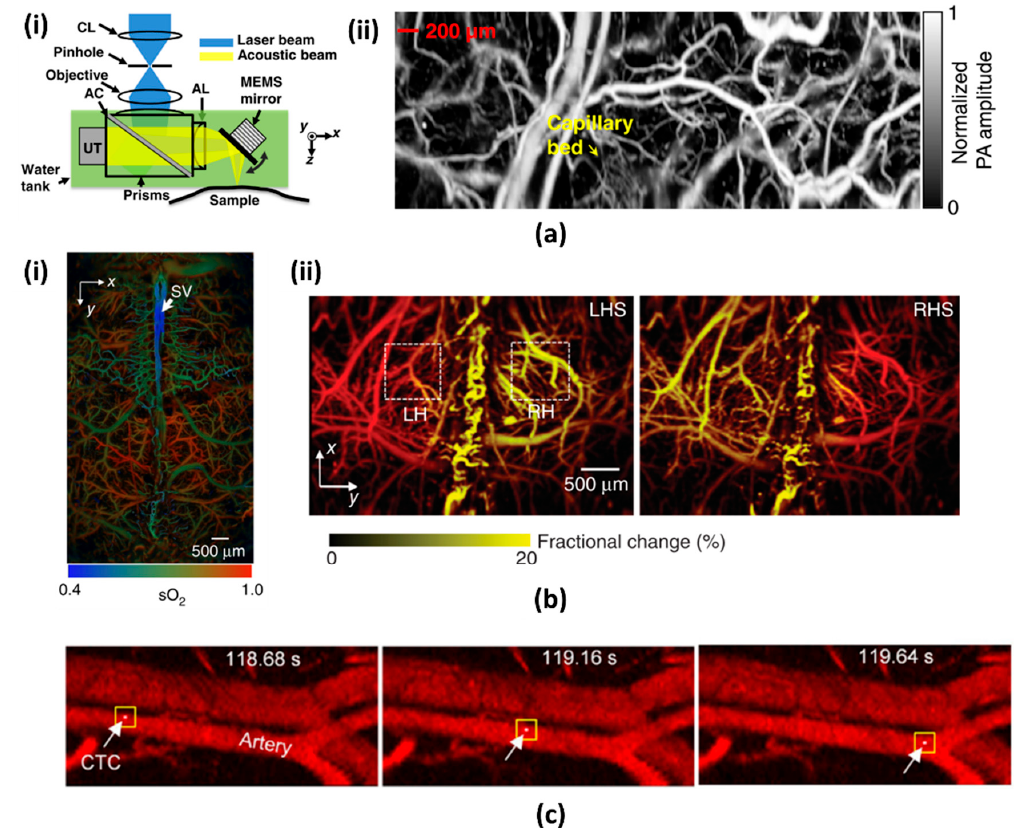
Figure 3. ( a ) A water immersible MEMS mirror based optical-resolution PAM (OR-PAM). ( ai